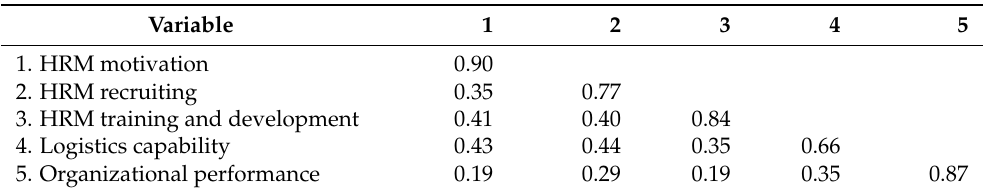
Table 2. Discriminant validity for the research model.